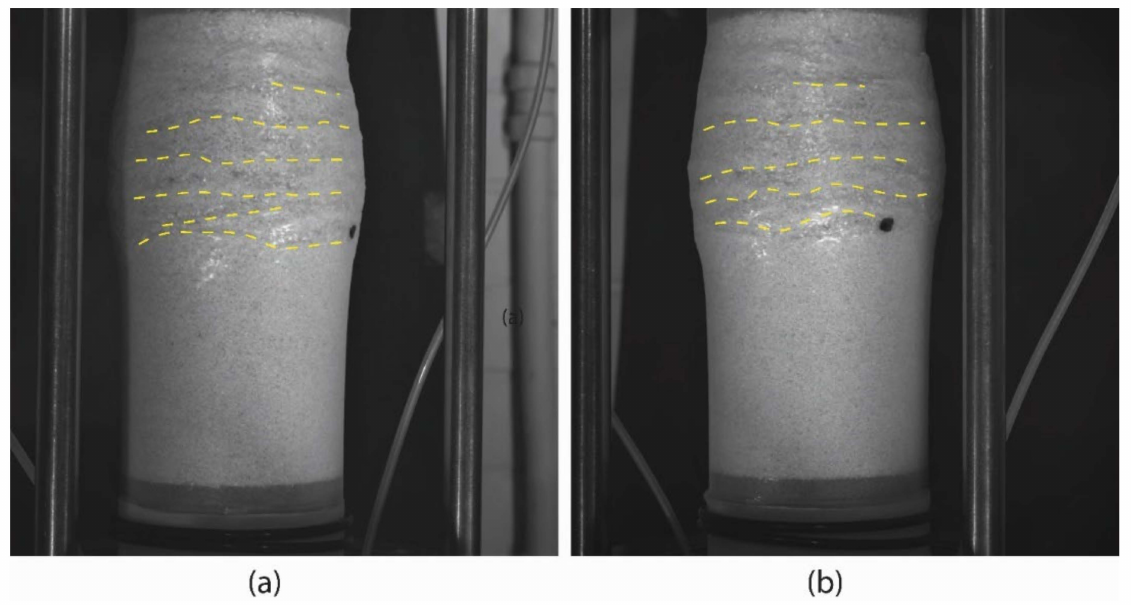
Figure 25. Digital images of test 120704c at axial strain 9.0%: ( a ) left image; ( b ) right image.